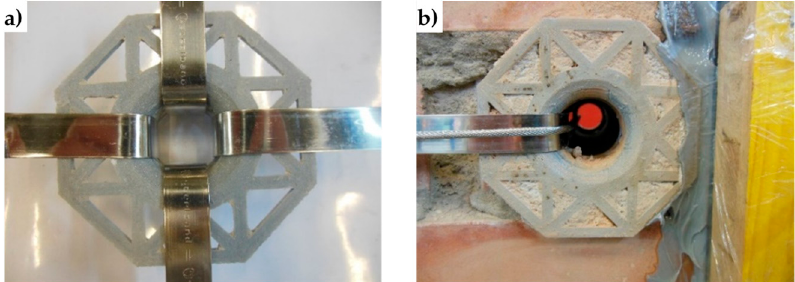
Figure 56. Funnel plates of the second combined technique: ( a ) arrangement of four pieces of steel ribbons to protect the rounded corners of the PLA funnel plates and ( b ) installation of a steel wire rope on a piece of steel ribbon, protecting the rounded corner of a PLA funnel plate.